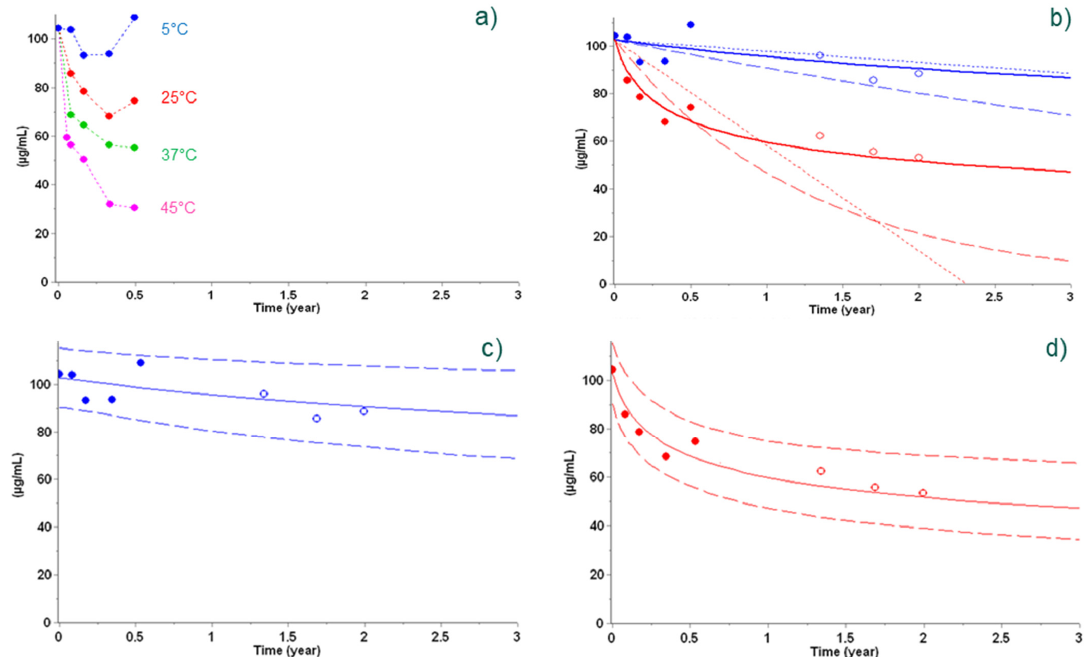
Figure 2. Stability data points used to build models (full circles) at +5 °C (blue), +25 °C (red), +37 °C (green), and +45 °C (pink) ( a ) and not used in the determination of the models (empty circles in panels ( b – d )) overlayed with predictions from empirical models (zero-order in dotted lines and first-order in dashed lines in panel ( b )) and best kinetic model (n th -order reaction in solid lines in panels ( b – d ). Prediction using the n th -order reaction in panels ( c , d )) is shown with a 95% prediction interval (dashed lines). Reproduced from Clénet et al. (2014), Copyright © 2014, with permission from Elsevier.